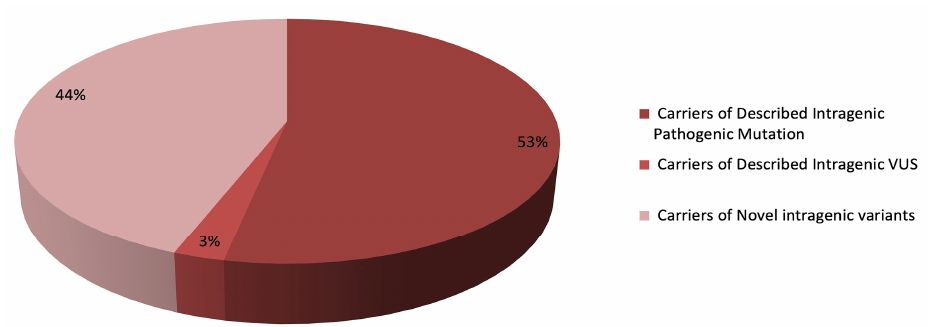
Figure 2. Percentage of carriers of intragenic variants. We show in dark red the patients carrying the described intragenic pathogenic mutation; in light red is shown the patients carrying the described intragenic VUS; in pink are patients carrying novel intragenic variants.